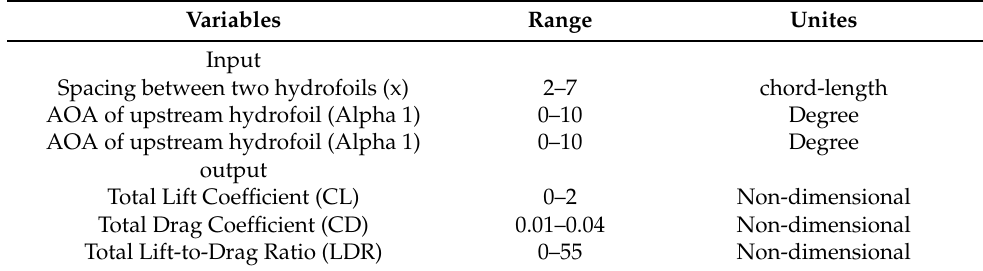
Table 6. Input and output ranges for